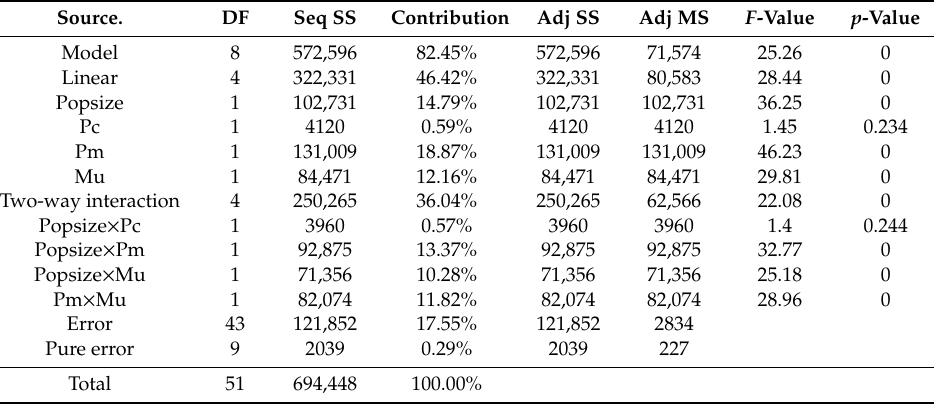
Table 6. Reduced ANOVA table for the central processing unit (CPU) time.